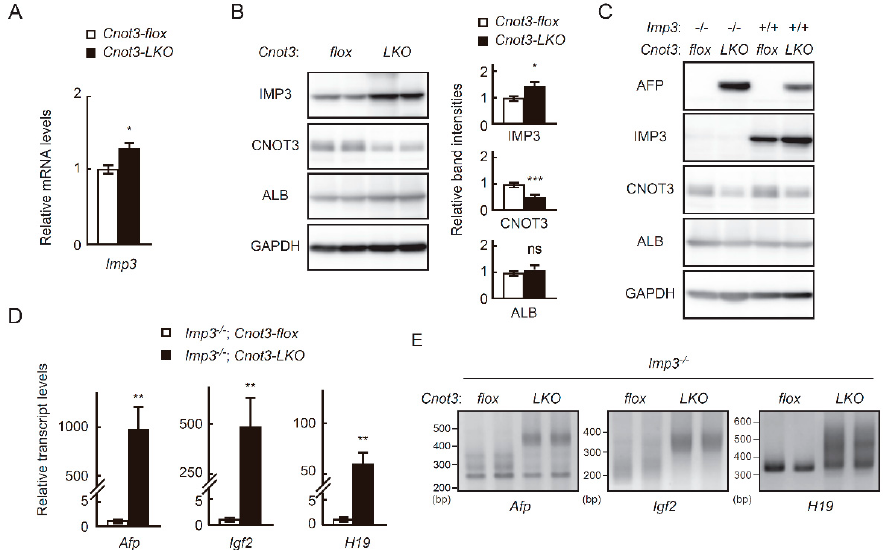
Figure 3. Increased levels and elongated poly(A) tails of Afp , H19 and Igf2 transcripts in Cnot3-LKO mice are not affected by an absence of IMP3. ( A ) qPCR of Imp3 mRNA in livers from 4 w control and Cnot3-LKO mice. Gapdh mRNA levels were used for normalization. The Imp3 level in control mice was set to 1 ( n = 3). Values in graphs represent means ± sem. * p < 0.05. ( B ) Immunoblot of indicated molecules in livers from 4 w control and Cnot3-LKO mice (two representatives of three different samples). Right graphs show quantification of the immunoblot data. Relative band intensities normalized to GAPDH levels are calculated ( n = 3). Values in control mice are set to 1. Data are presented as means ± sem. * p < 0.05, *** p < 0.001. ( C ) Immunoblot of indicated molecules in livers from control, Imp3 − / − ; Cnot3-flox , Cnot3-LKO , and Imp3 − / − ; Cnot3-LKO mice. ( D ) qPCR analysis of the indicated transcripts in livers from 4 w Imp3 − / − ; Cnot3-flox and Imp3 − / − ; Cnot3-LKO mice. Gapdh mRNA levels were used for normalization. Levels in Imp3 − / − ; Cnot3-flox mice are set to 1 ( n = 3). Values in graphs represent means ± sem. ** p < 0.01. ( E ) Comparison of poly(A) tail lengths of the indicated transcripts in livers from 4 w Imp3 − / − ; Cnot3-flox and Imp3 − / − ; Cnot3-LKO mice.